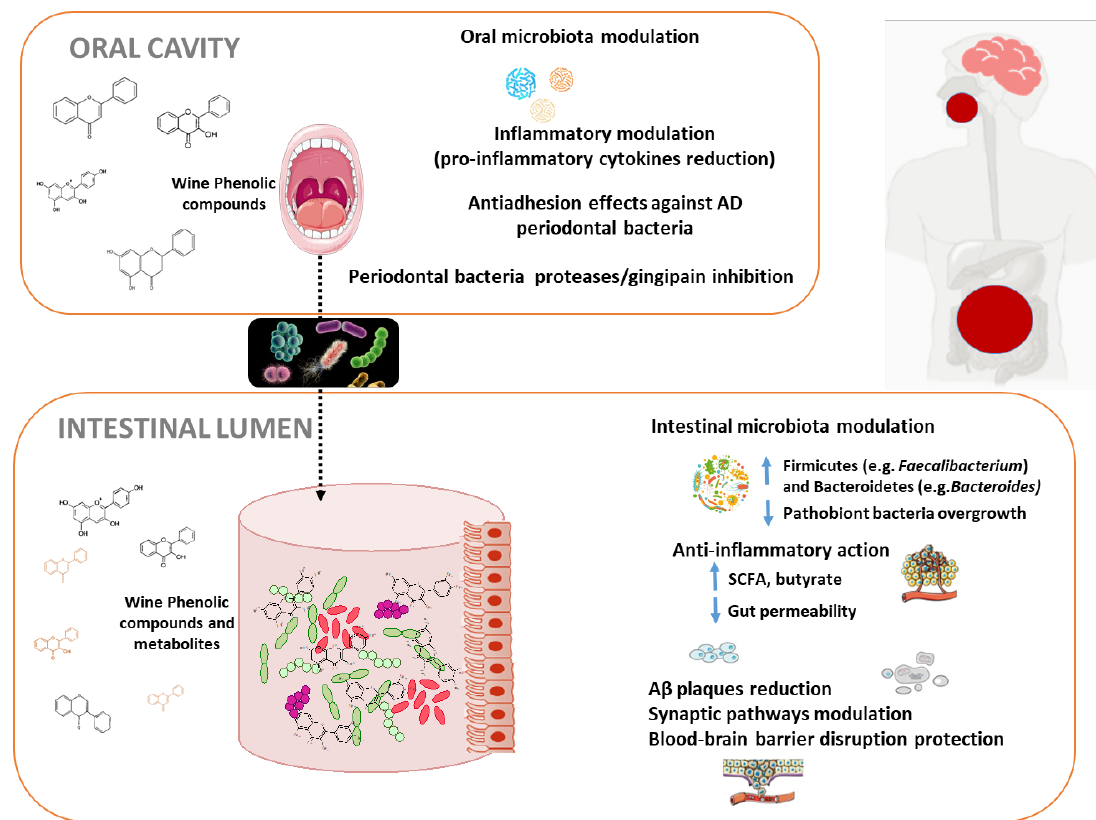
Figure 2. Schematic view illustrating the putative mechanisms underlying the interaction of wine polyphenols with oral and gut microbiota and protection against Alzheimer’s disease. AD: Alzheimer´s disease, SCFA: Short Chain Fatty Acids, Aβ: amyloid-β